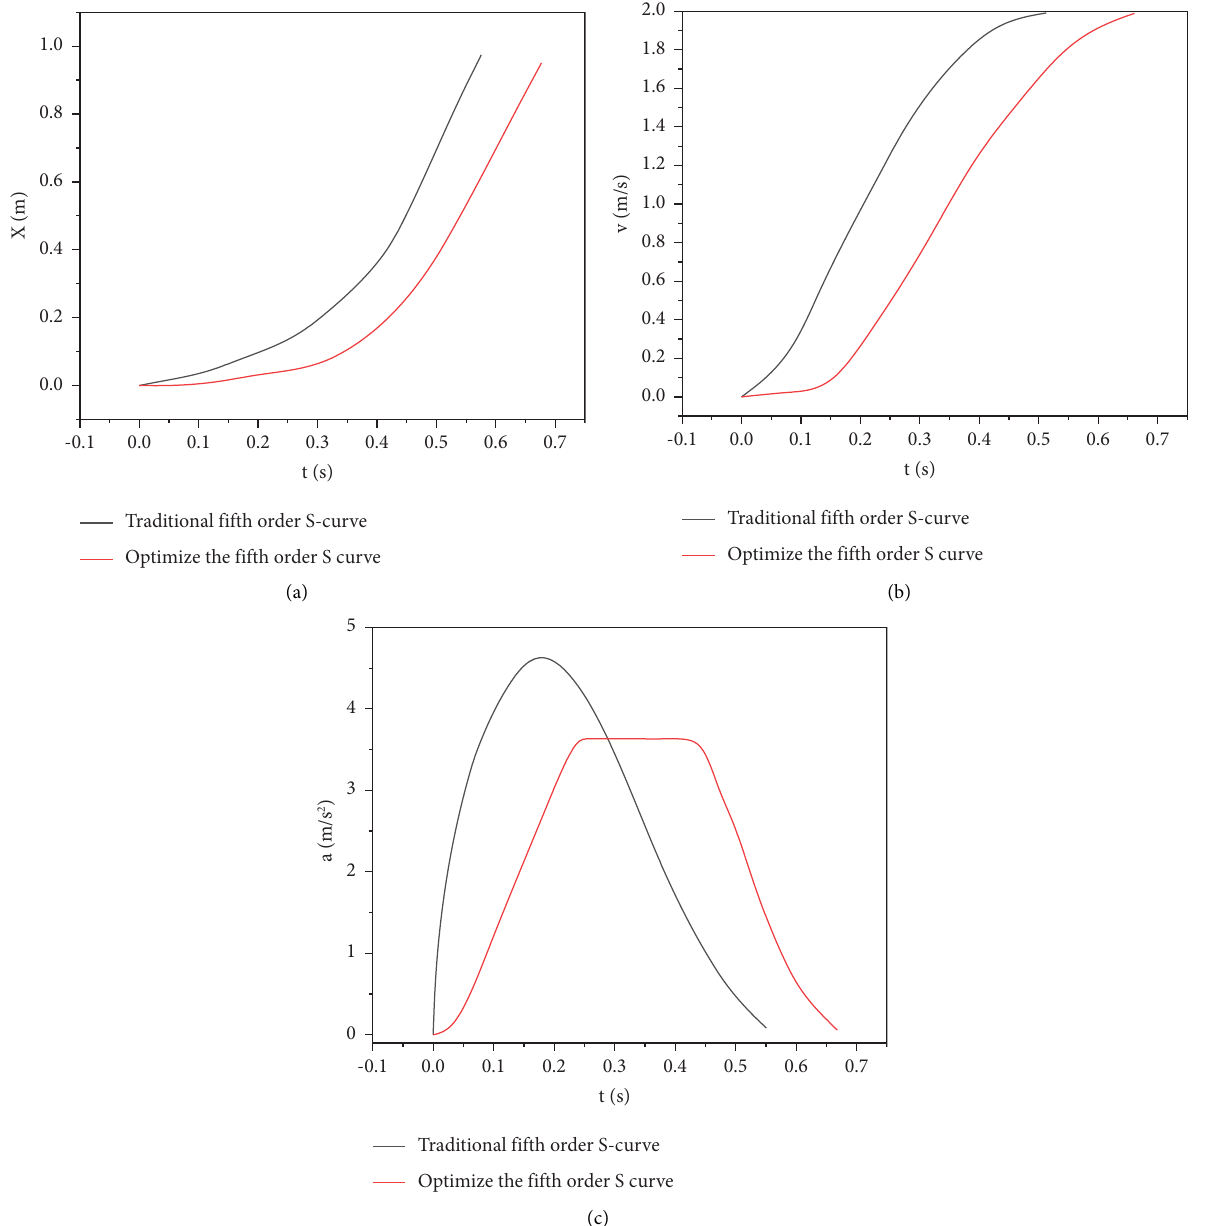
Figure 9: Simulation curves of diferent algorithms: (a) displacement curve, (b) velocity curve, and (c) acceleration